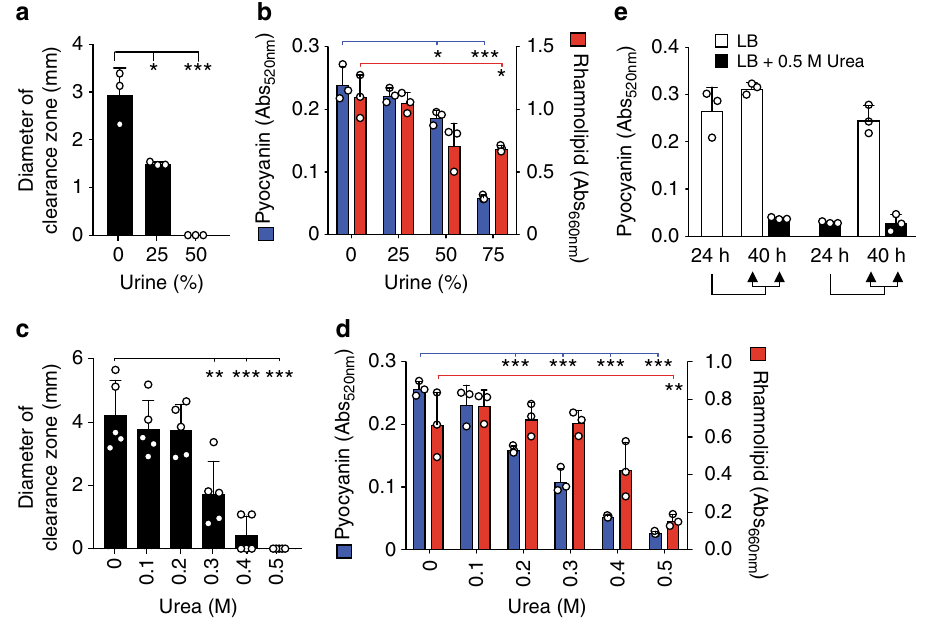
Fig. 2 Urine and urea suppress quorum-regulated phenotypes. P. aeruginosa grown in 1× phosphate-buffered saline + 1% tryptone (PBS-T) supplemented with increasing concentrations of human urine was quanti fi ed for a zone of clearance around bacterial colony grown on milk plates, b pyocyanin (red bars) and rhamnolipid (blue bars) production. P. aeruginosa grown in LB supplemented with increasing amounts of urea was quanti fi ed for c zone of clearance around colonies grown on milk plates, d pyocyanin (red bars) and rhamnolipid (blue bars) production. e Quanti fi cation of pyocyanin produced by P. aeruginosa after 24-h growth in the presence or absence of 0.5 M urea followed by 16-h subculture growth in the presence or absence of 0.5 M urea. Data represent the mean and standard deviation of at least three independent replicates and were analyzed by unpaired t -test using GraphPad Prism software. Asterisk (*, **, and ***) indicates p < 0.05, <0.01, and <0.001,